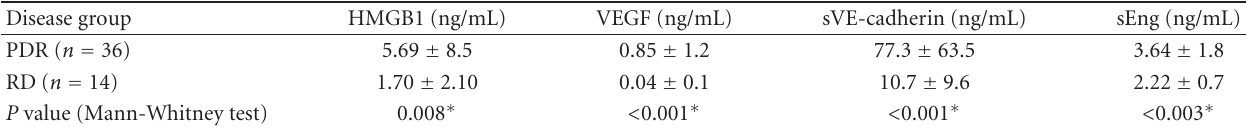
Table 1: Comparisons of mean angiogenesis biomarker levels in proliferative diabetic retinopathy (PDR) and rhegmatogenous retinal detachment (RD) patients.